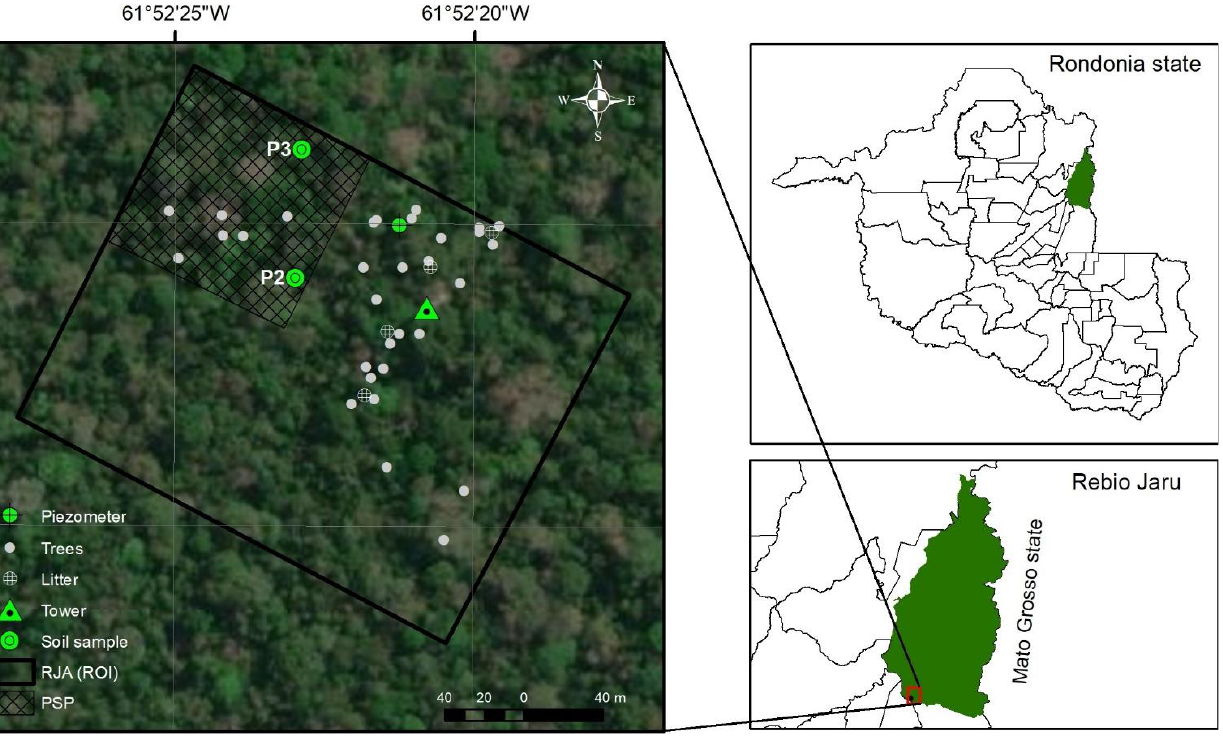
Figure 1. Location of study area. PSP = LBA permanent sub-plot, where were made the forest inventory; ROI = region of interest; Source: shapefile of the Rondonia state and Rebio Jaru from https://downloads.ibge.gov.br (accessed on 1 December 2021).